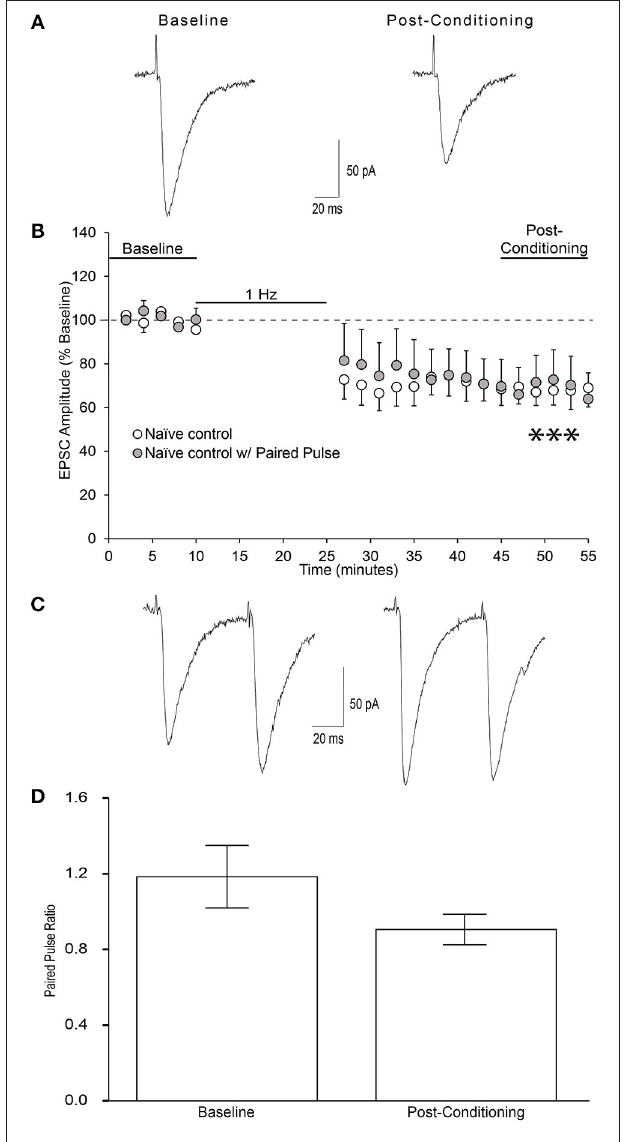
FIGURE 6 | Low-frequency stimulation produces LTD at glutamatergic synapses onto AIC layer 2/3 pyramidal neurons. (A) Representative traces from a single neuron showing evoked EPSCs before and 20–30min after low-frequency conditioning stimulation protocol (900 pulses at 1Hz while holding the neuron at − 70mv). (B) Conditioning stimulation induced long-term depression of evoked EPSCs onto AIC layer 2/3 pyramidal neurons of ethanol-naïve mice (12 neurons/12 slices/9 mice, *** p = 0.0007 compared to baseline). (C) Representative traces from a single neuron showing evoked paired pulse ratios before baseline and after the post-conditioning period. (D) Bar graph representing the mean PPR ± S.E.M. before baseline and after the post-conditioning period. PPR was determined by dividing the amplitude of EPSC2 by EPSC1 for each sweep. Average PPRs before baseline and after post-conditioning were not significantly different ( n = 6 neurons/6 slices/4 mice; paired t -test, t = 2.48, n/s). Values are expressed as averages ± S.E.M.